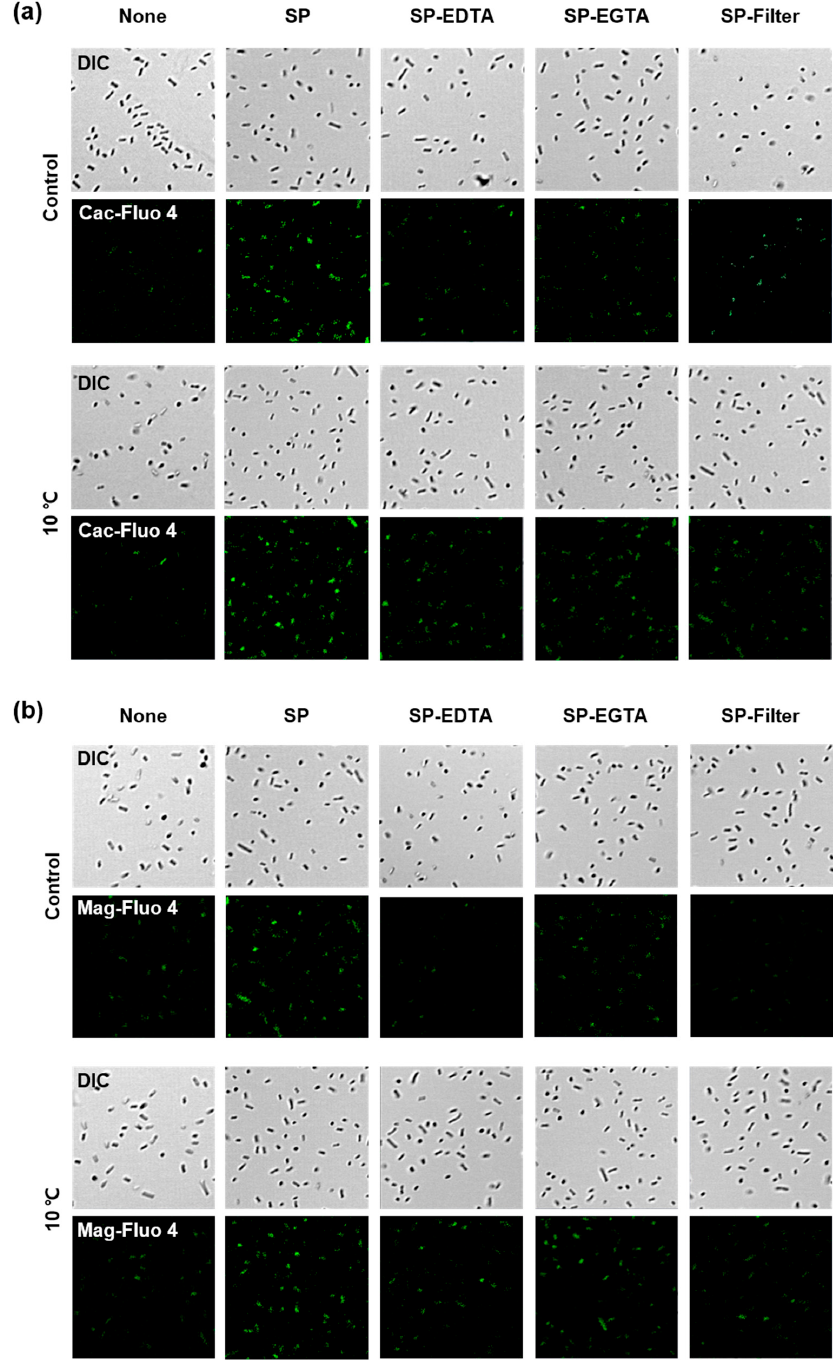
Figure 3. Cold adaption enhances Cation influx into L. brevis WiKim0069 cells in the presence of soy powder. Confocal micrographs revealing Ca 2+ ( a ) and Mg 2+ ( b ) influx into L. brevis WiKim0069 cells under different cryoprotective conditions. SP: Soy powder extract; SP-EDTA: Soy powder pretreated with EDTA; SP-EGTA: Soy powder pretreated with EGTA; SP-Filter: Soy powder pretreated with a cation